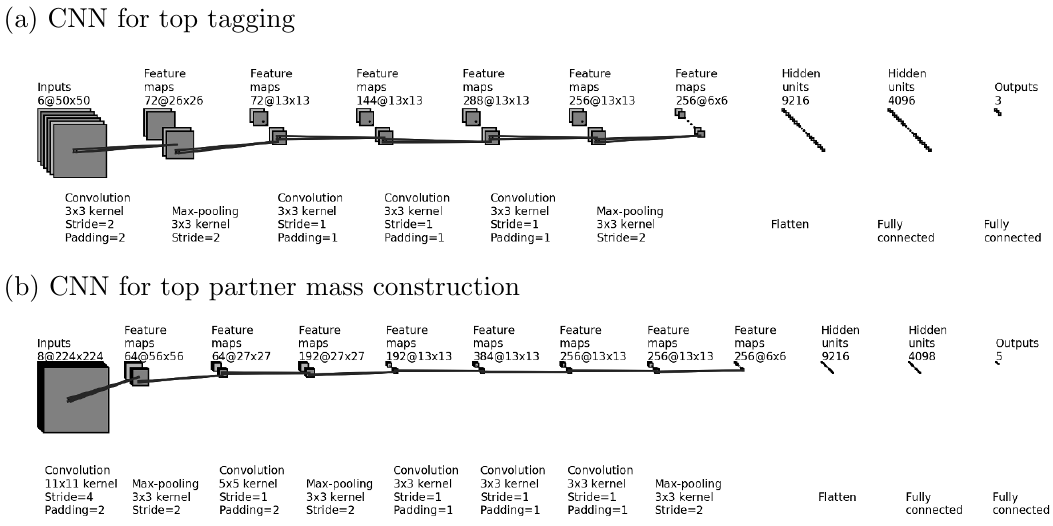
Figure 6 . The structure of the CNN used for top tagging (upper panel) and top partner mass construction (lower